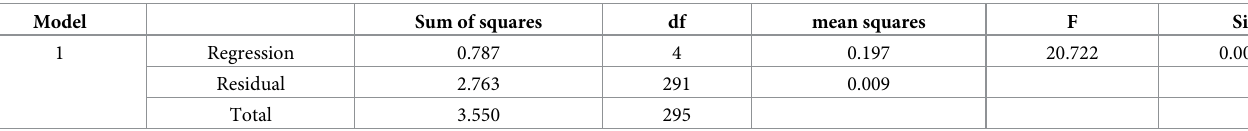
Table 10. Results of one-way ANOVA.